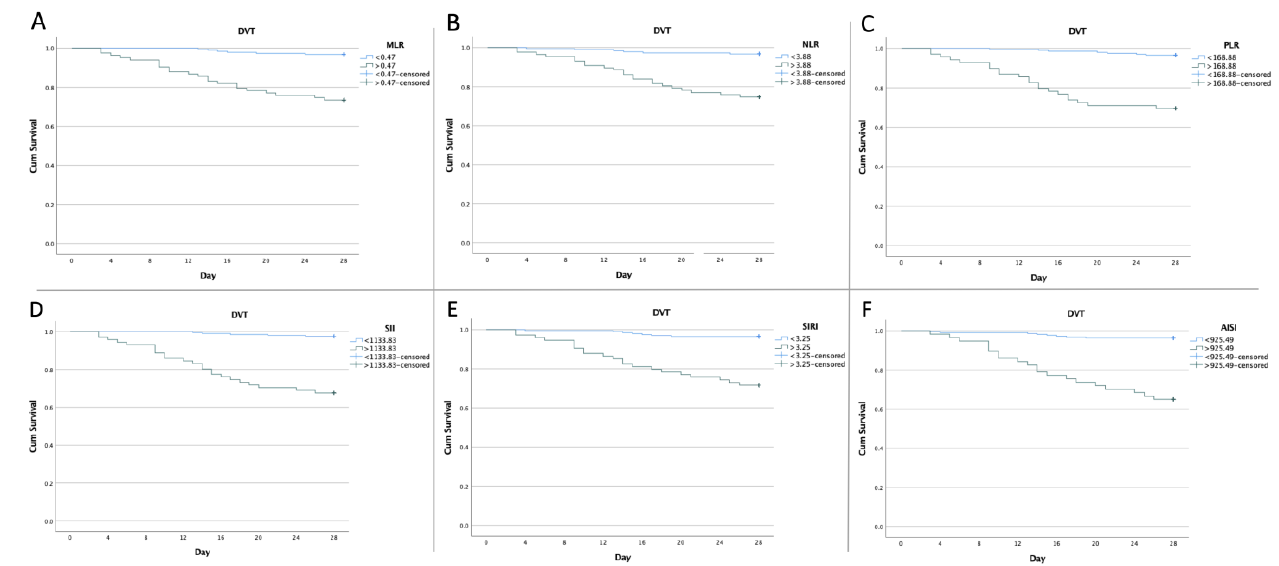
Figure 2. Kaplan – Meier curves showing DVT risk ( A ) according to MLR optimal cut off value ( p <0.001; log-rank p ), ( B ) according to NLR optimal cut-off value ( p < 0.001; log-rank p ), ( C ) according to PLR optimal cut-off value ( p < 0.001; log-rank p ), ( D ) according to SII optimal cut-off value ( p < 0.001; log-rank p ), ( E ) according to SIRI optimal cut-off value ( p < 0.001; log-rank p ), and ( F ) according to AISI optimal cut-off value ( p < 0.001; log-rank p ).